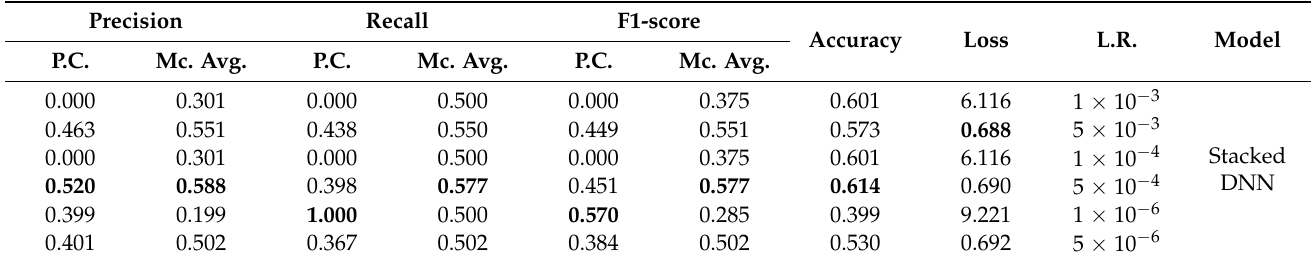
Table 1. Comparison of performance measures based on the MFCC features alone (P.C. is the positive class, L.R. is the learning rate, and Mc. Avg. is the macro-average).